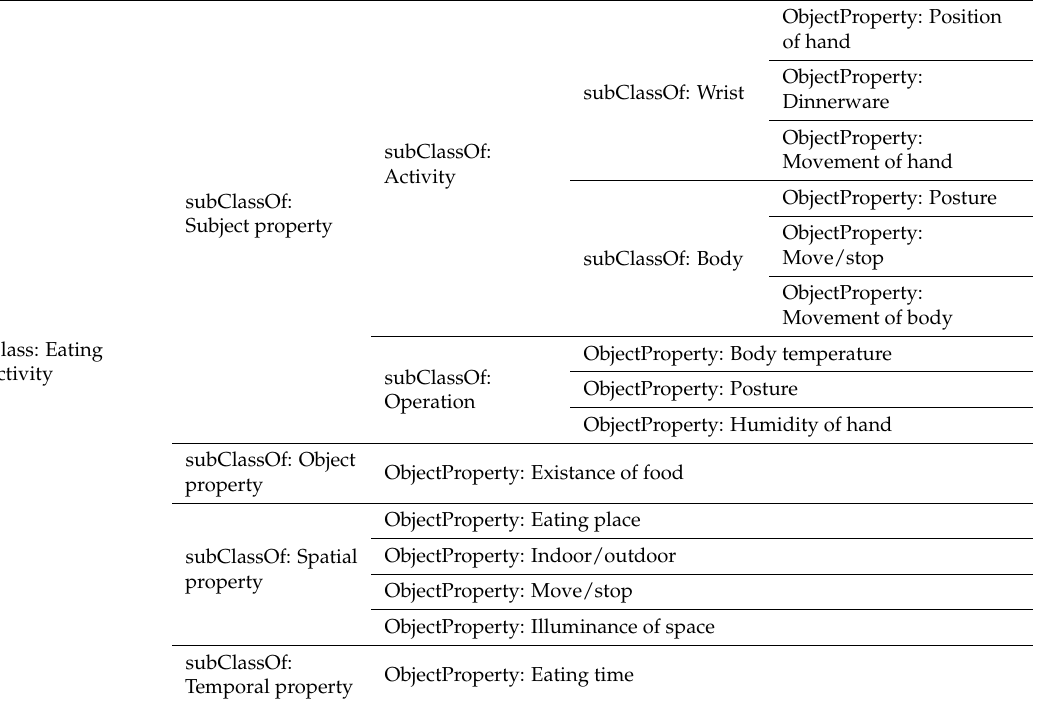
Table 5. OWL representation of the context model for eating activity